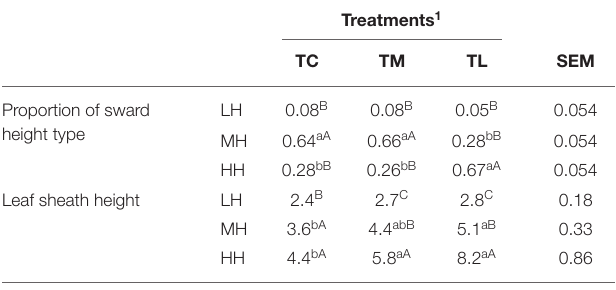
TABLE 1 | Proportion of low height (LH), medium height (MH), and high height (HH) of sward and leaf sheath height (cm) 1 day before grazing according to the treatments.